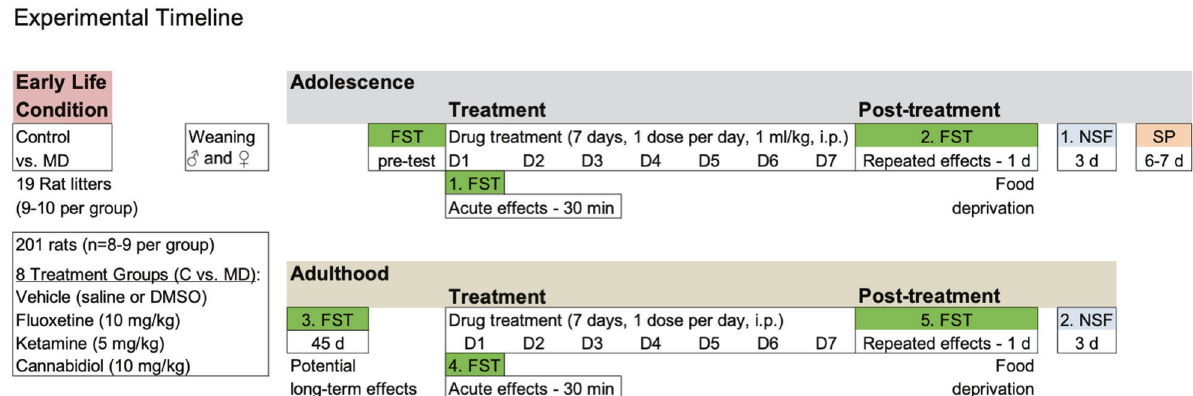
Fig. 1 Experimental timeline. A total of 201 rats were exposed in early-life to maternal deprivation (MD) or control conditions, followed by a battery of behavioral tests (FST forced-swim, NSF novelty-suppressed feeding, SP sucrose preference) in mid/late-adolescence and adulthood during and/or following drug treatment (vehicle, ketamine, cannabidiol, and fl uoxetine). D day of treatment, d day